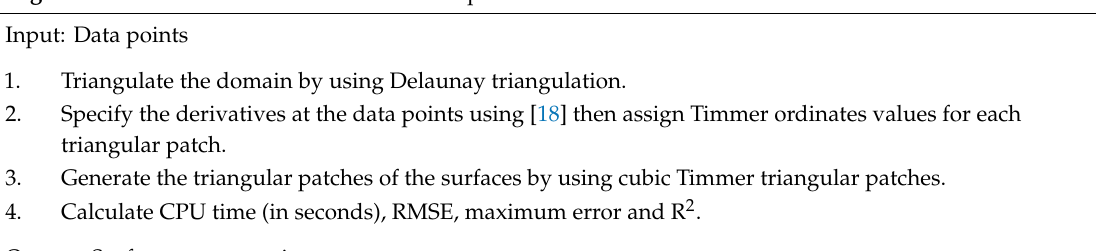
Algorithm 1. Construction scattered data